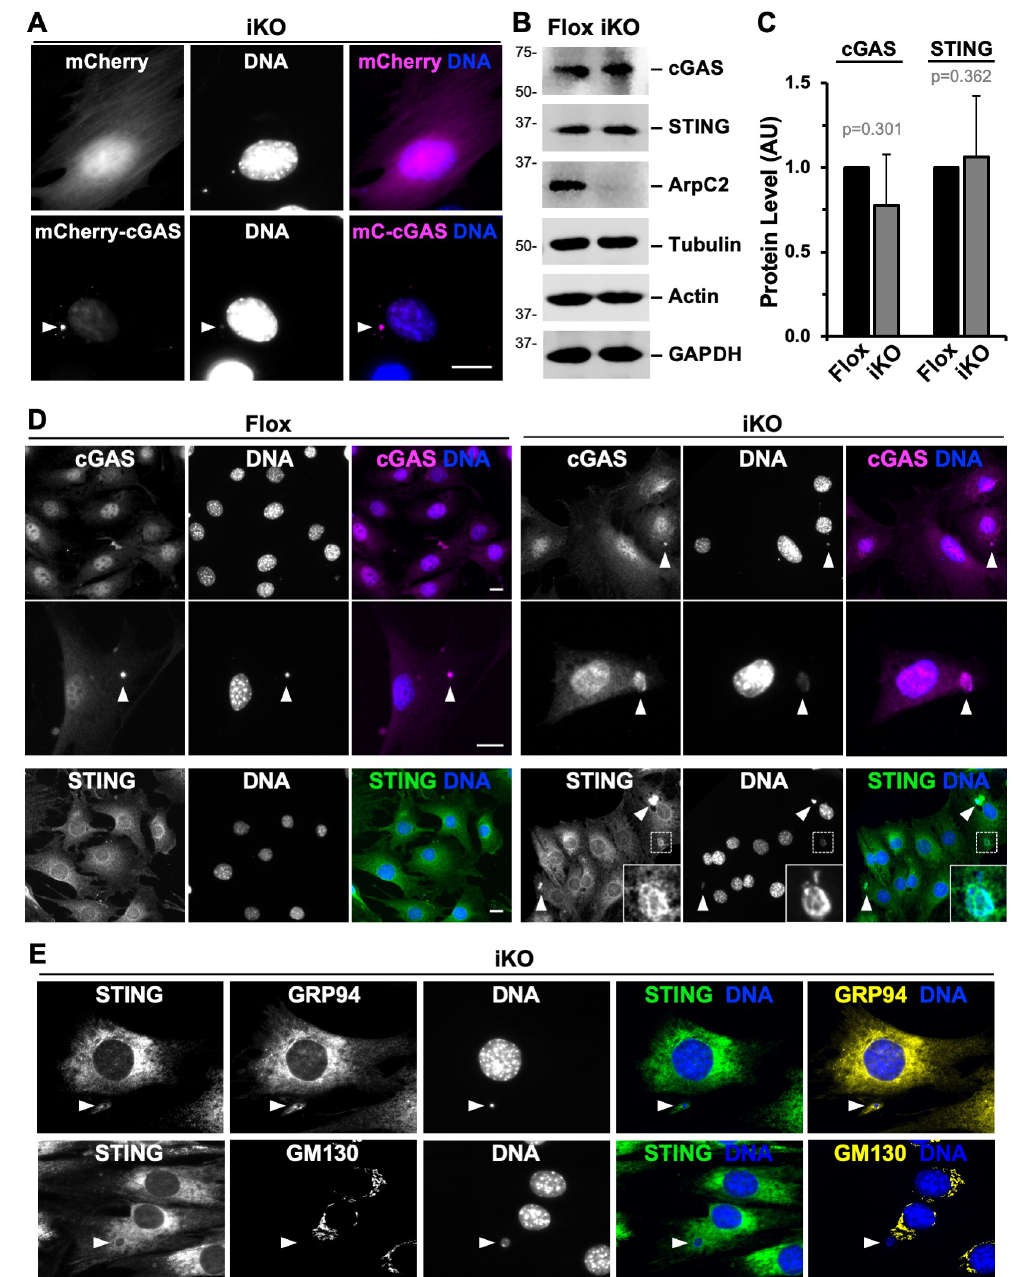
Fig 10. cGAS and STING are recruited to micronuclei. (A) Mouse fibroblasts were transfected with plasmids encoding mCherry or mCherry-cGAS (magenta), treated with 4-OHT (iKO), fixed at 1-2d, and stained with DAPI (DNA; blue). Arrowheads point to a cGAS-positive micronucleus. Scale bars, 20 μ m. (B) Cells were treated with DMSO (Flox) or 4-OHT (iKO) for 3-4d and immunoblotted with antibodies to cGAS, STING, ArpC2, tubulin, actin, and GAPDH. (C) cGAS and STING band intensities were normalized to tubulin, actin, and GAPDH band intensities. Each bar represents the mean intensity ± SD from n = 3 or 6 experiments. (D) Flox and iKO cells were fixed at 3d and stained with cGAS (magenta) or STING (green) antibodies and DAPI. Arrowheads point to cGAS- or STING-positive micronuclei. 38.7% of micronuclei in iKO cells were cGAS-positive (75 cells evaluated from 2 experiments). Insets show STING localization around an iKO micronucleus. (E) iKO cells were fixed at 6d and stained with antibodies to STING (green) and either GRP94 or GM130 (yellow).